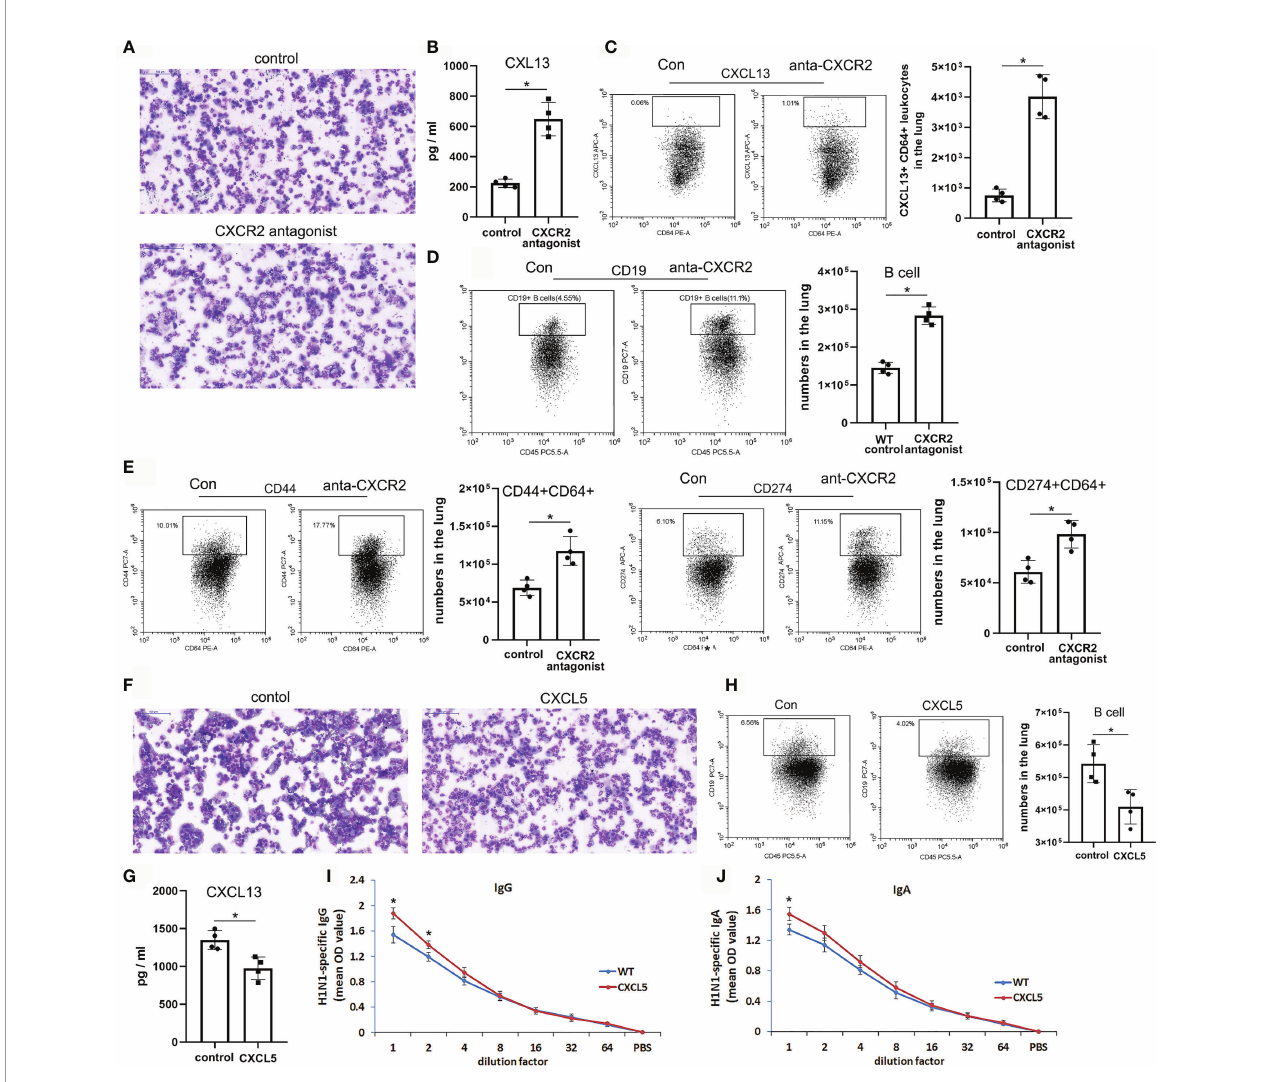
FIGURE 7 | CXCL5-CXCR2 signaling regulated pulmonaryneutrophiland B cellrecruitment and CXCL13 production from lungmacrophages uponH1N1 infection. (A – E) WTmice were infected with H1N1 virus(1000 CCID 50 ) and treated with either CXCR2 antagonist orPBS as a control during 1-3 d.p.i. Microscopic view of BALF leukocytes from the infected mice collected at 3 d.p.i.and cytospun (×400 magni fi cation) (A) . The protein level of CXCL13 in the BALF of the infected mice was measured at 3 d.p.i. by ELISA (n=4) (B) . Percentages andnumbersof CXCL13-expressing cellsamongpulmonary CD64+ cells (C) , CD19+ B cells (D) , andCD44+/CD274+ CD64+ cells (E) from the infectedmice at3 d.p.i.by fl ow cytometry andcounting (n=4). (F – J) WT mice were infected with H1N1 virus (1000 CCID 50 ) and orotracheally instilled with either CXCL5 recombinant protein orPBS as a control during5-8 d.p.i.Microscopic view of BALF leukocytes fromthe infected mice collectedat 8 d.p.i.and cytospun (×400 magni fi cation) (F) . The protein level ofCXCL13 in the BALF ofthe infected mice was measured at 8 d.p.i.byELISA (n=4) (G) . Percentages andnumbersof CD19+ B cells fromthe infected mice at 8 d.p.i. by fl ow cytometryand counting (n=4) (H) . Measurements of H1N1-speci fi c IgG (I) and IgA (J) inthe BALF of the CXCL5treatment and control mice at 8 d.p.i. (n = 4). The error bars represent the SDsof4 samples. *P < 0.05 based on Student ’ s t